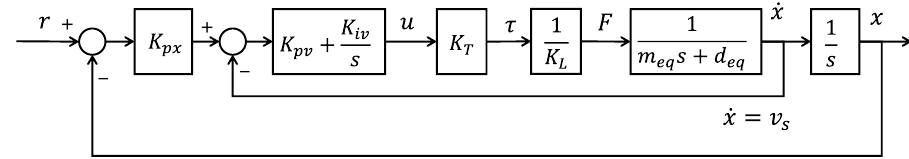
Figure 5. Block diagram of the actuator position control by the torque control.